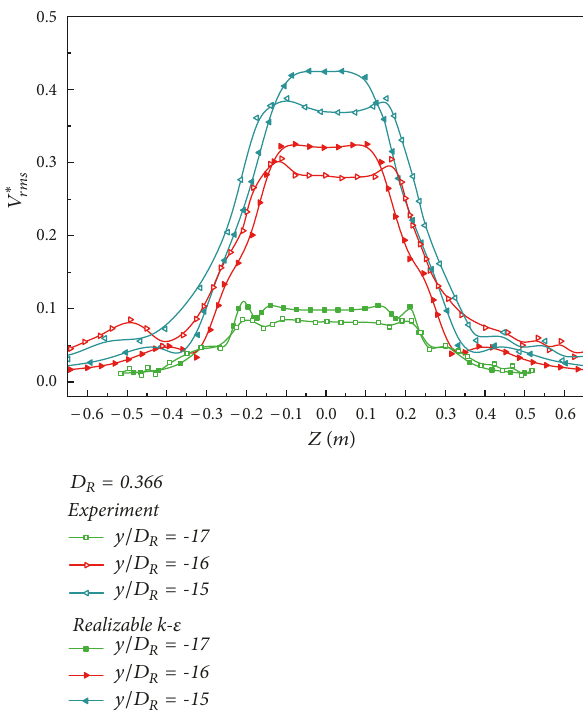
Figure 7: Comparison of dimensionless RMS velocity between numerical data and experimental data.